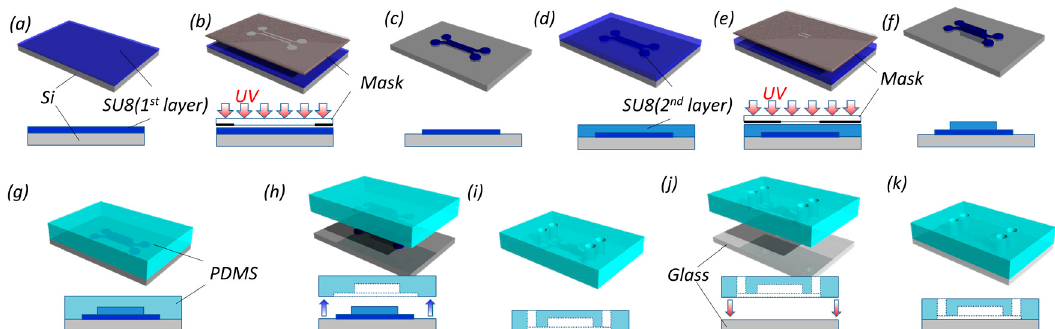
Figure A1. Fabrication of the microfluidic chip. The device consists of inlets, outlets, cell trap chambers. ( a – f ) Step-by-step photolithography for mold fabrication; ( g – k ) the step-by-step procedure for PDMS chip fabrication from the mold. PDMS and glass are integrated by plasma bonding.